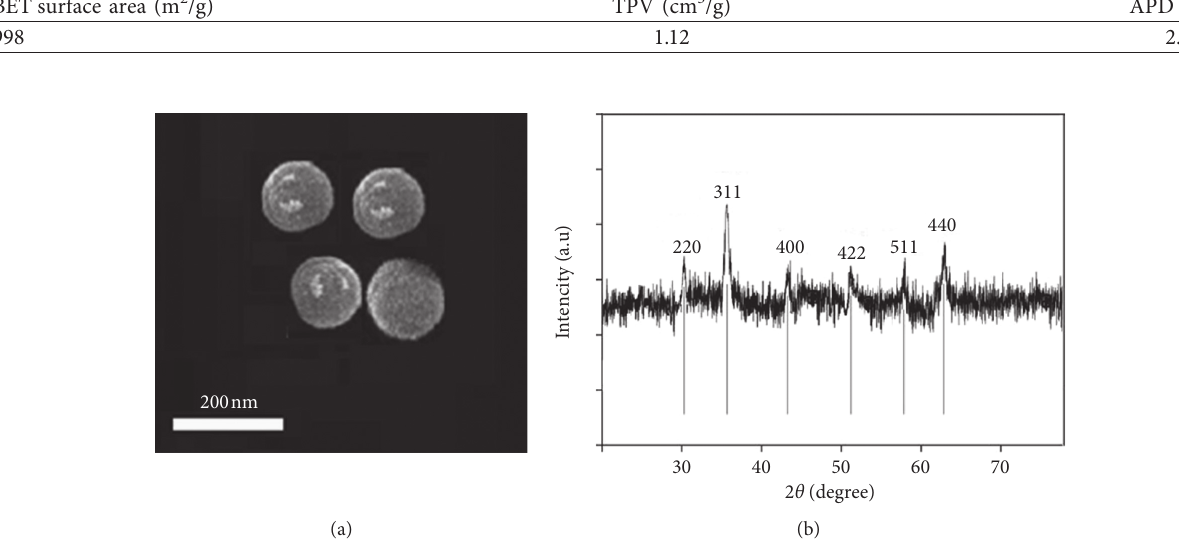
Figure 2: (a) TEM and (b) XRD results of FAC. Table 3: The elemental analysis (wt%) of FAC and OBC